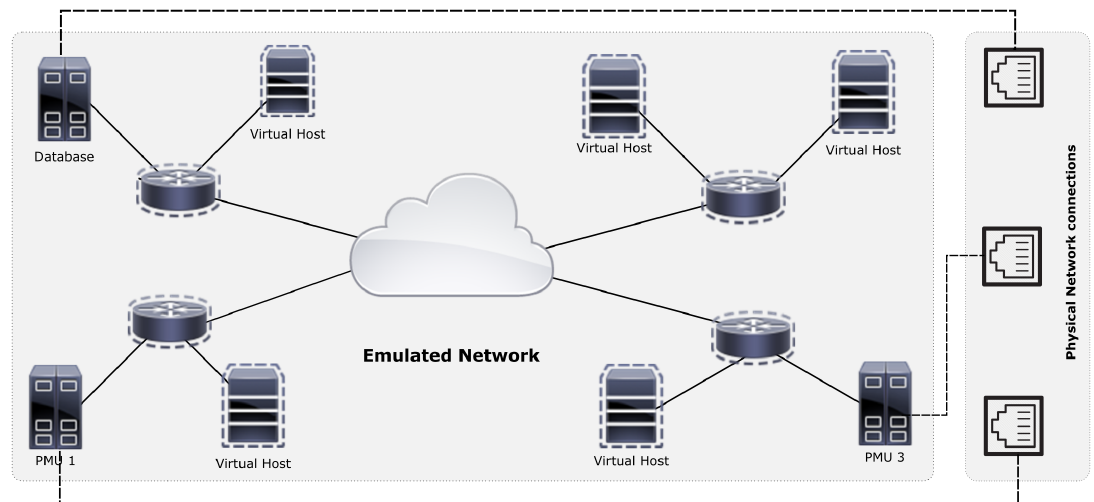
Figure 4. The communication network model consisting of different subnets with virtual (dotted outlined) and real hosts. These subnets are connected to each other through routers. The cloud here is used to represent a wide area network. The Ethernet port schematic shows the nodes that are connected to the physical